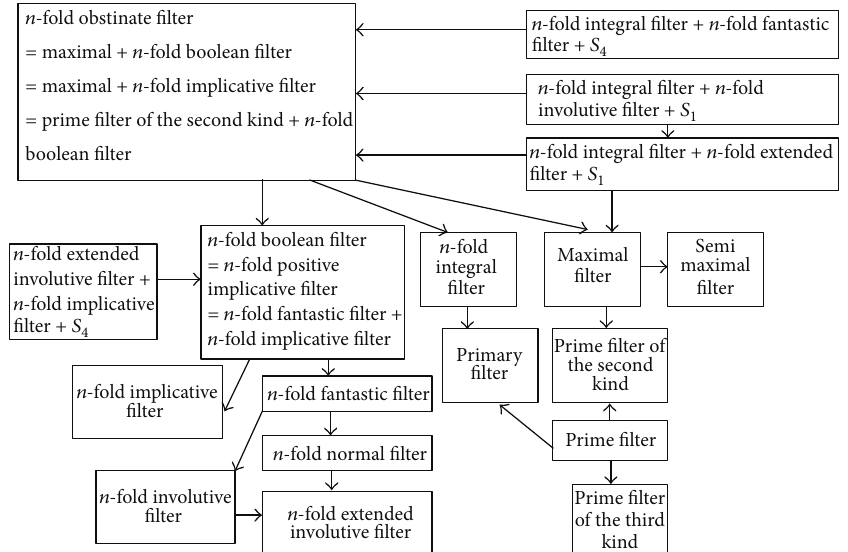
Figure 1: Diagram of 𝑛 -fold filters.